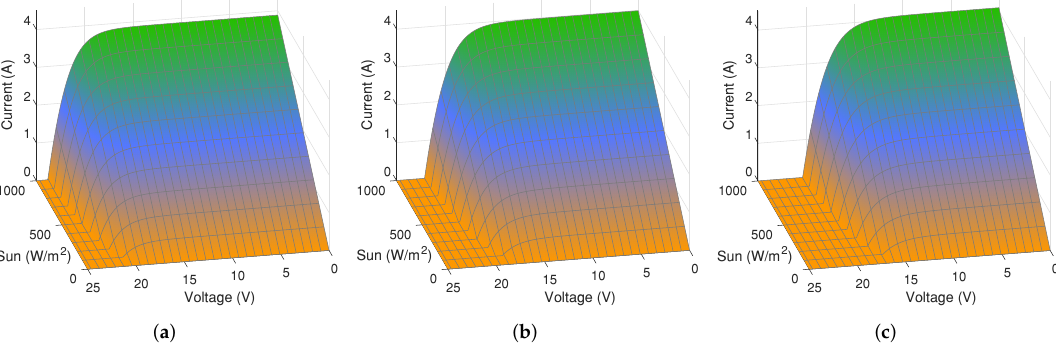
Figure 2. BP365 PV module characteristic at ( a ) T = 0 ◦ C, ( b ) T = 25 ◦ C, ( c ) T = 50 ◦